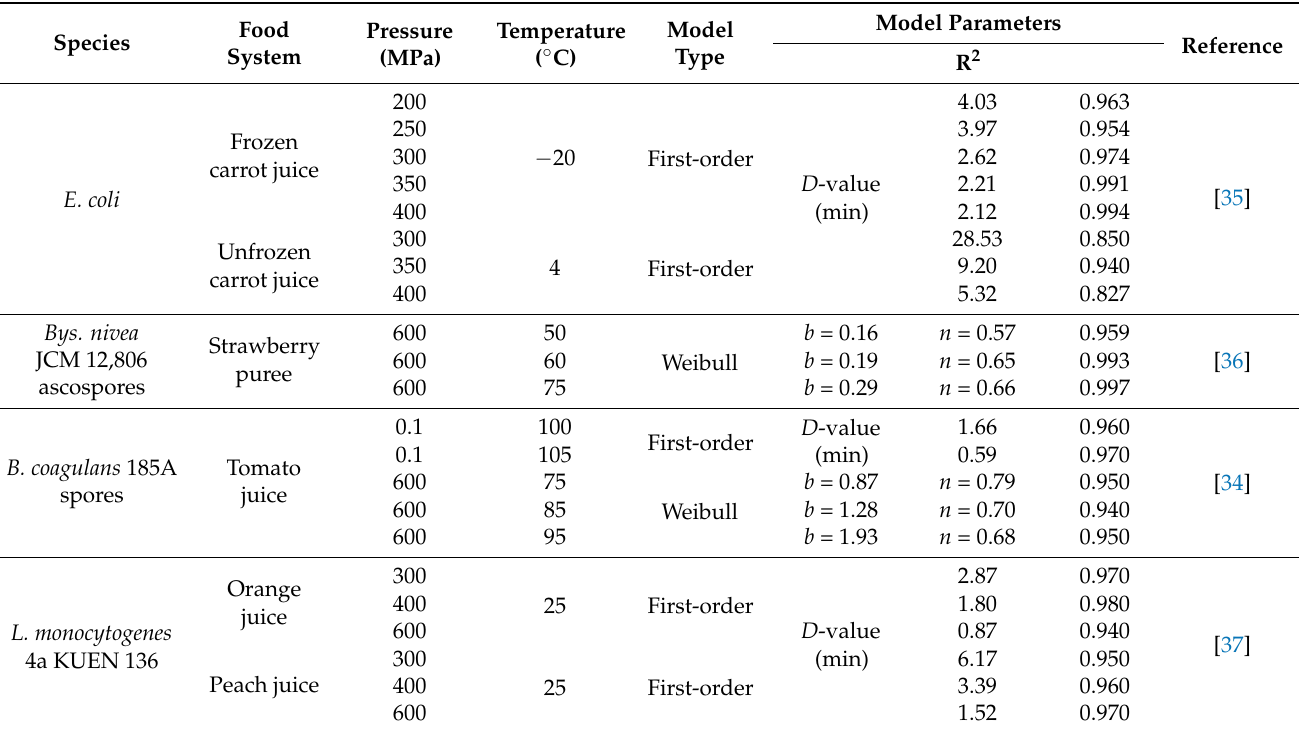
Table 1. Application of HPP and HPTP bactericidal kinetic models in different fruit and vegetable